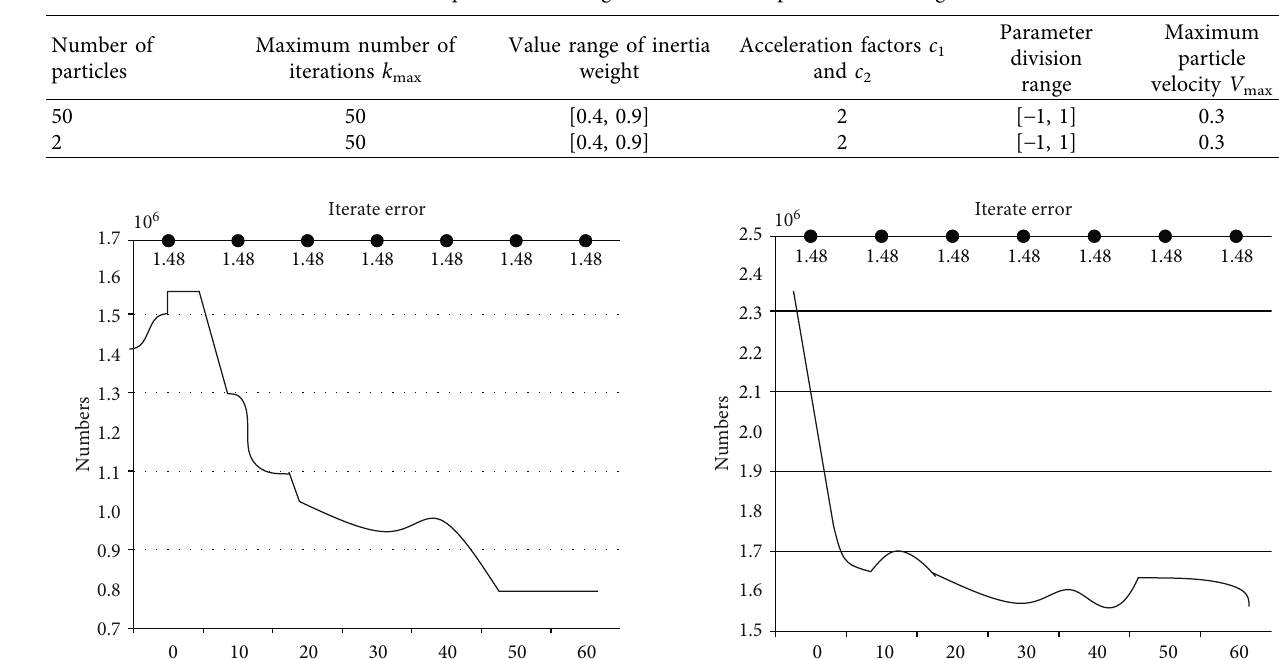
Figure 7: The prediction results of the PSO-ELM algorithm. (a) Test results of PSO-ELM algorithm and (b) iteration Table 3: The parameter settings of the modified particle swarm algorithm.